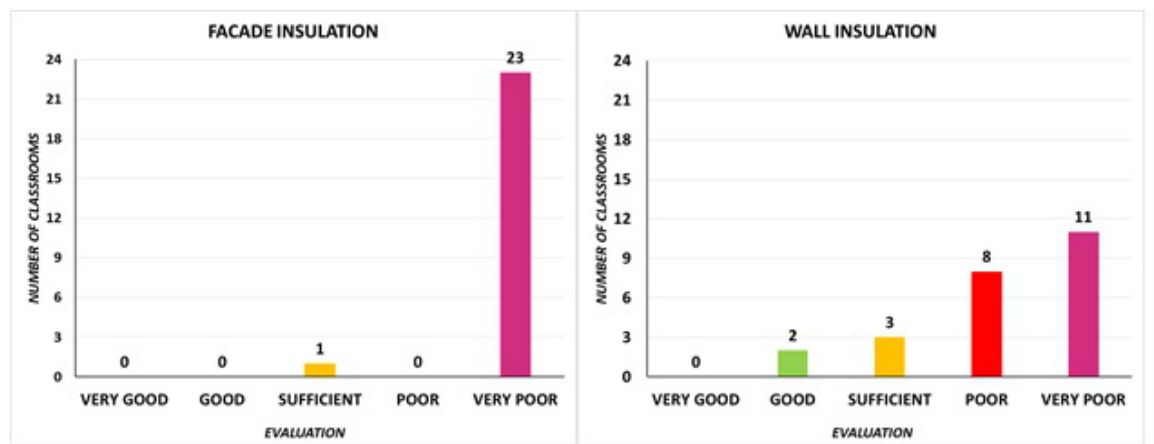
Figure 2: Day equivalent level outside and inside the rooms.